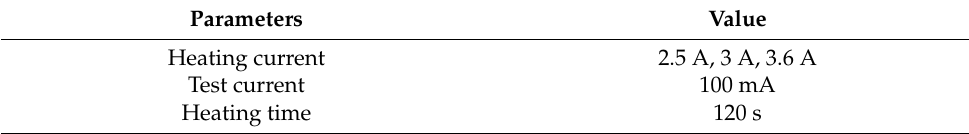
Table 1. Test conditions for V ds measurements.